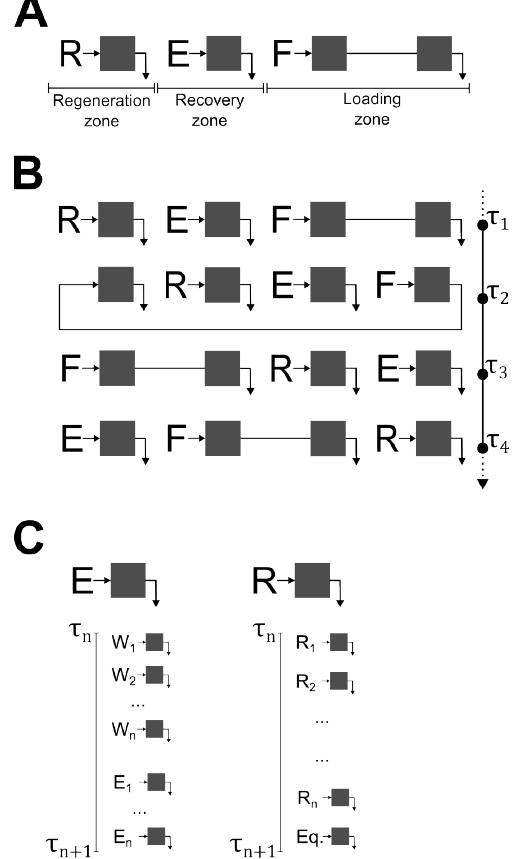
Figure 1. Schematic of a four-column periodic counter-current process. ( A ) Chromatography zones: a recovery zone for product elution, a regeneration zone for cleaning in place and re-equilibration, and a loading zone with two columns connected in series. ( B ) Operating cycle, composed of four switching intervals ( τ ) of equal duration. ( C ) Description of elution and regeneration zones and possible substeps; W 1 to W n , E 1 to E n , R 1 to R n , and Eq. denote the several steps for washing, elution, column regeneration, and column equilibration,